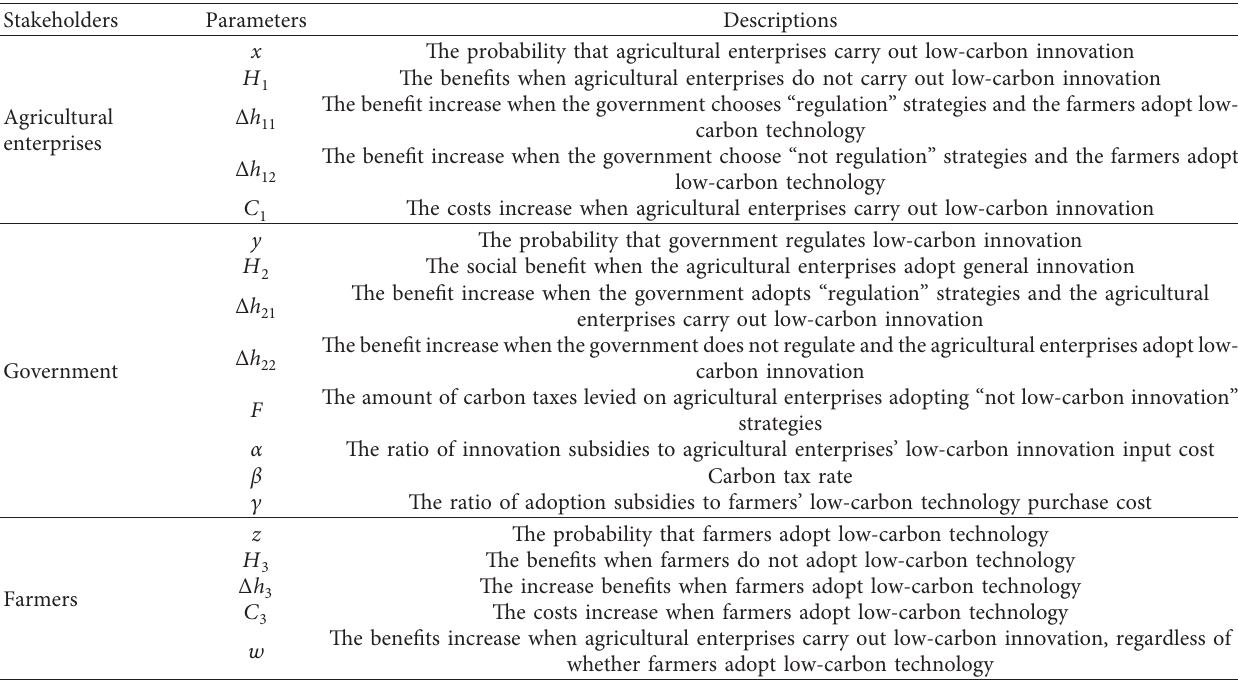
Table 1: Parameter descriptions.